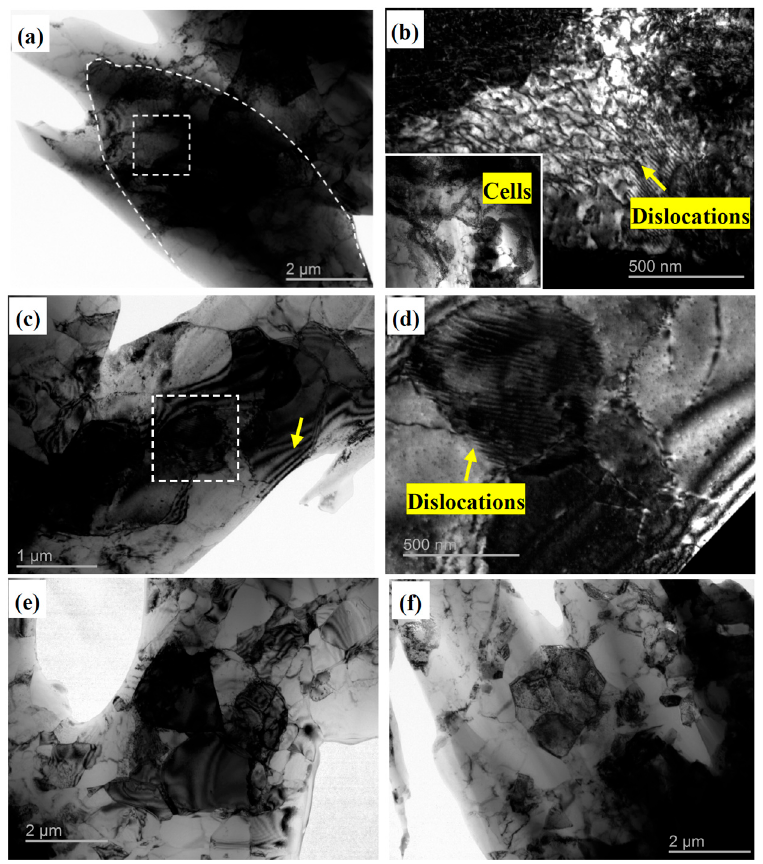
Figure 7. Typical TEM micrographs of Al-5 wt % TiB 2 /TiC composites: ( a , b ) After rolling for 90% reduction; ( c , d ) After one ARB cycle; ( e ) After two ARB cycles; ( f ) After four ARB cycles.